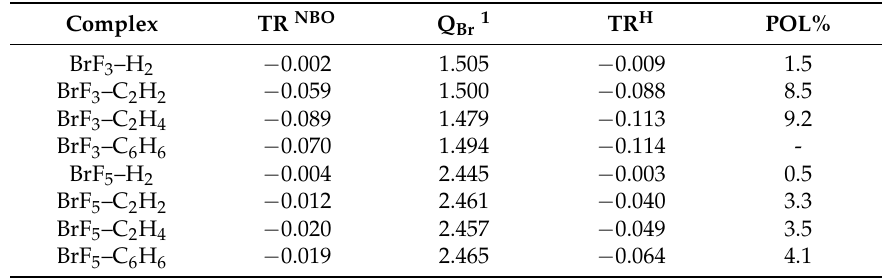
Table 4. The electron charge parameters; TR NBO (in au) is the NBO electron charge transfer from the Lewis base to the Lewis acid; TR H is the same transfer (au) but calculated from Hirshfeld charges; Q Br is the NBO charge of bromine (au), POL% is the mean percentage increase of the Br-F equatorial bond polarization. Complex TR NBO Q Br 1 TR H